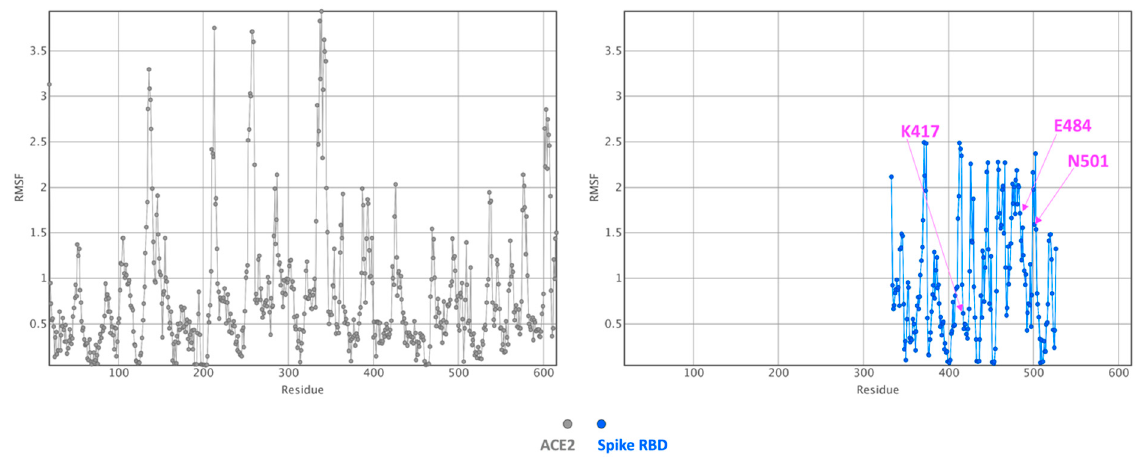
Figure 4. Fluctuation plot obtained for the Spike RBD–ACE2 complex. The residue fluctuation profile (RMSF in Å) as computed with CABS-Flex is shown (ACE2, in grey and the Spike domain, in blue). Substituted residues in this region of the Spike protein in the UK strain (N501) and in the South African strain (K417N, E484K, N501Y) are labelled in magenta.